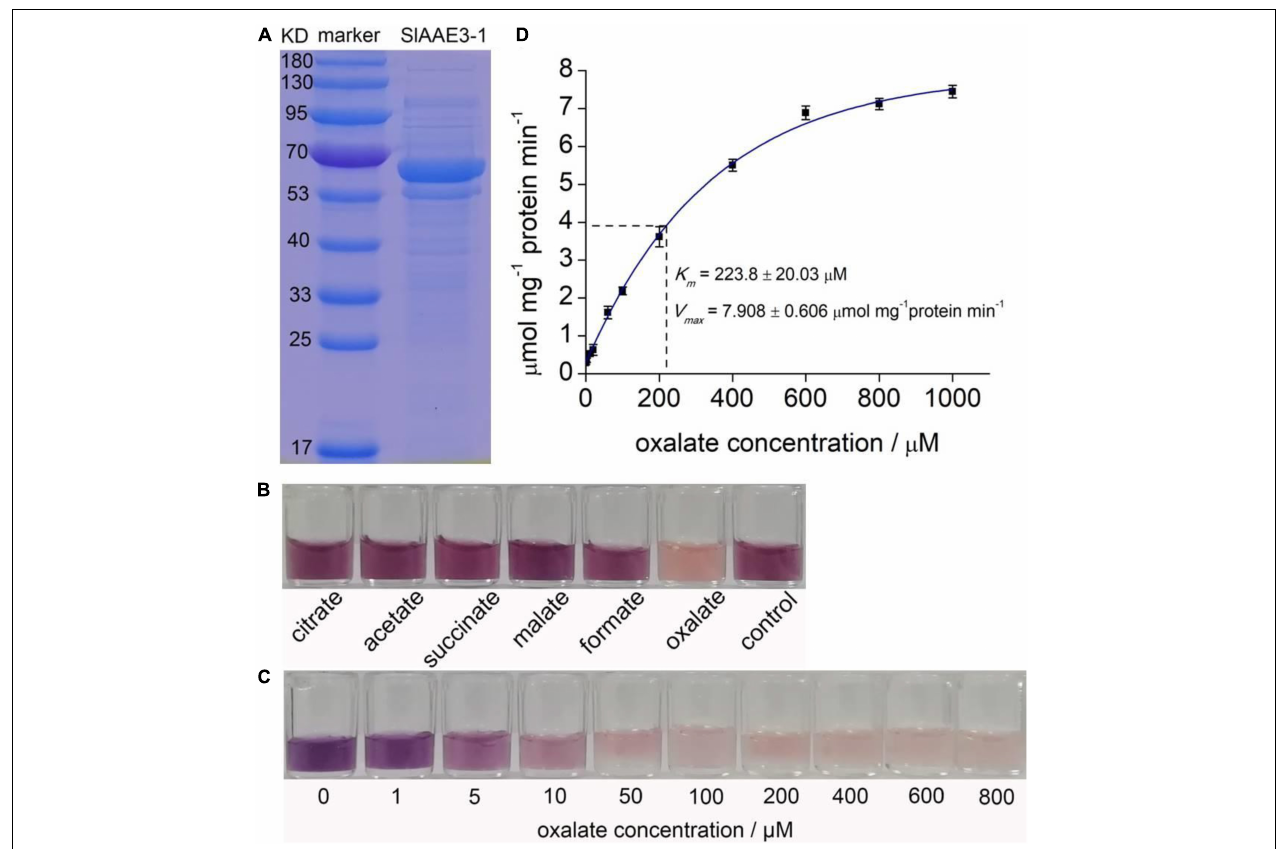
FIGURE 3 | Biochemical analysis of SlAAE3-1. (A) SDS-PAGE gel of purified SlAAE3-1 protein (right) and molecular weight markers (left). (B) Reaction activity of SlAAE3-1 against different organic acids. NADH residue level indicated by nitroblue tetrazolium and 1-methoxy-5-methylphenazinium methosulfate. (C) Visual inspection of NADH residue level indicated by nitroblue tetrazolium and 1-Methooxy-5-methylphenazinium methosulfate. The reaction assay consumed more NADH as oxalate increased. (D) Kinetics assay of SlAAE3-1.